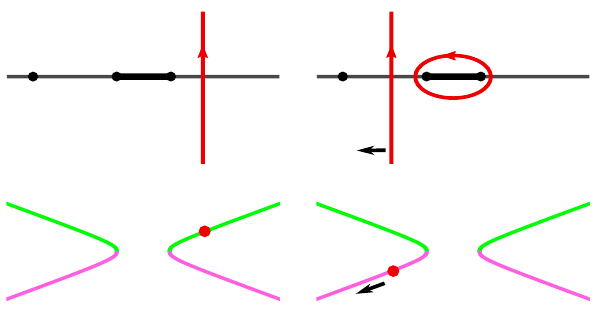
Figure 11 . The movement of contours along the J L trajectory past the branch cut around ν = i . As the contour is dragged further to the left along the J 3 solution it will pick up residues of the cosecant function when J 3 ( ν ) is an integer.